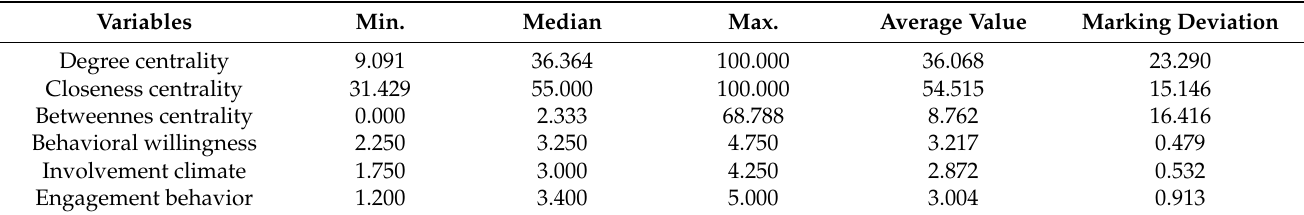
Table 5. Results of descriptive statistical analysis.